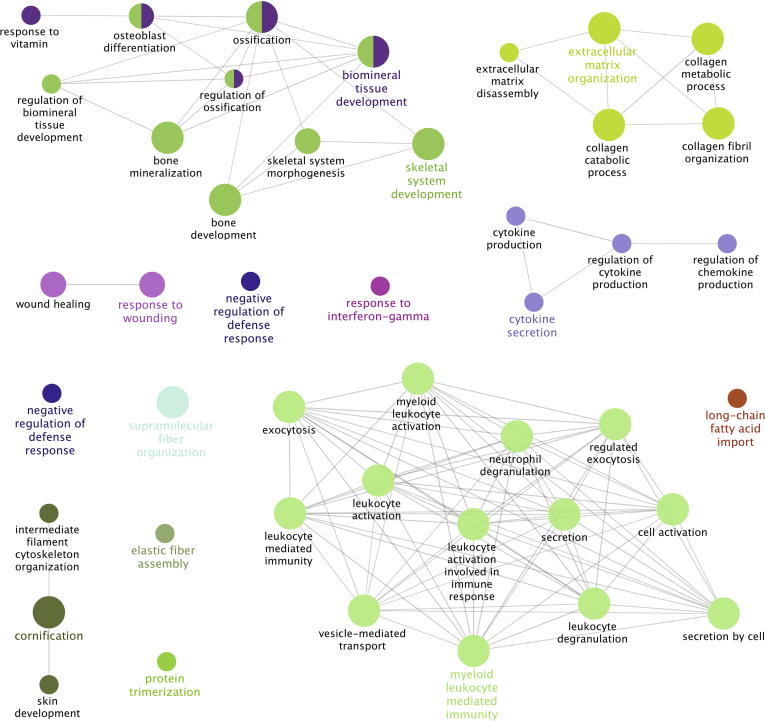
Integrative network analysis of serum and tissue proteomic data for HOProteins that were differentially expressed either in serum (n = 90) or tissue (n = 281) samples between HO+ and HO− cohorts, regardless of detection methodologies, were combined and analyzed collectively with ClueGO, and the significant non-redundant biological GO terms (P < 0.05) for the differentially-expressed proteins were displayed. The label and nodes of each cluster are colored by the most significant GO term in the cluster. Nodes showing 2 colors are included in multiple clusters. Node size reflects Kappa score. GO, gene ontology.